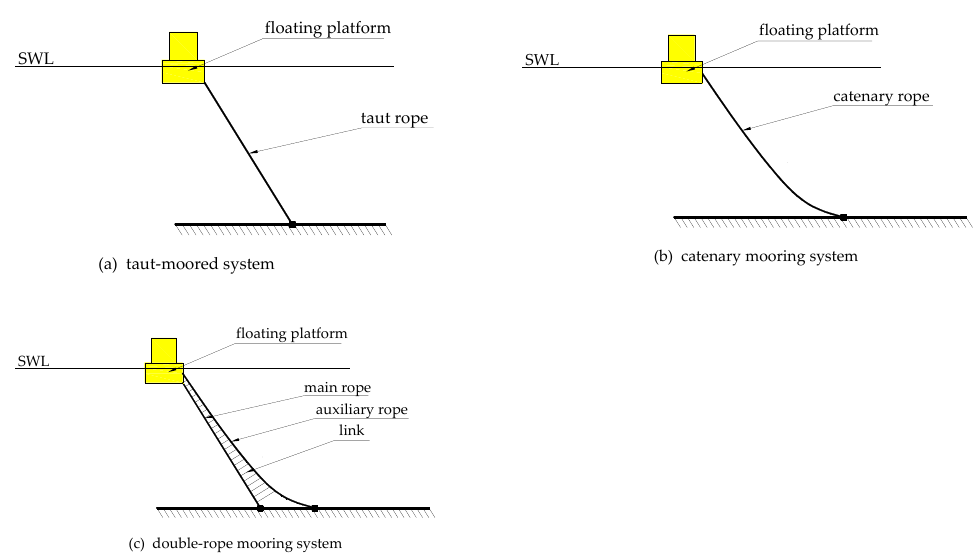
Figure 2. Schematic diagrams of three mooring systems: ( a ) Taut-moored system; ( b ) Catenary mooring system; ( c ) Double-rope mooring system.